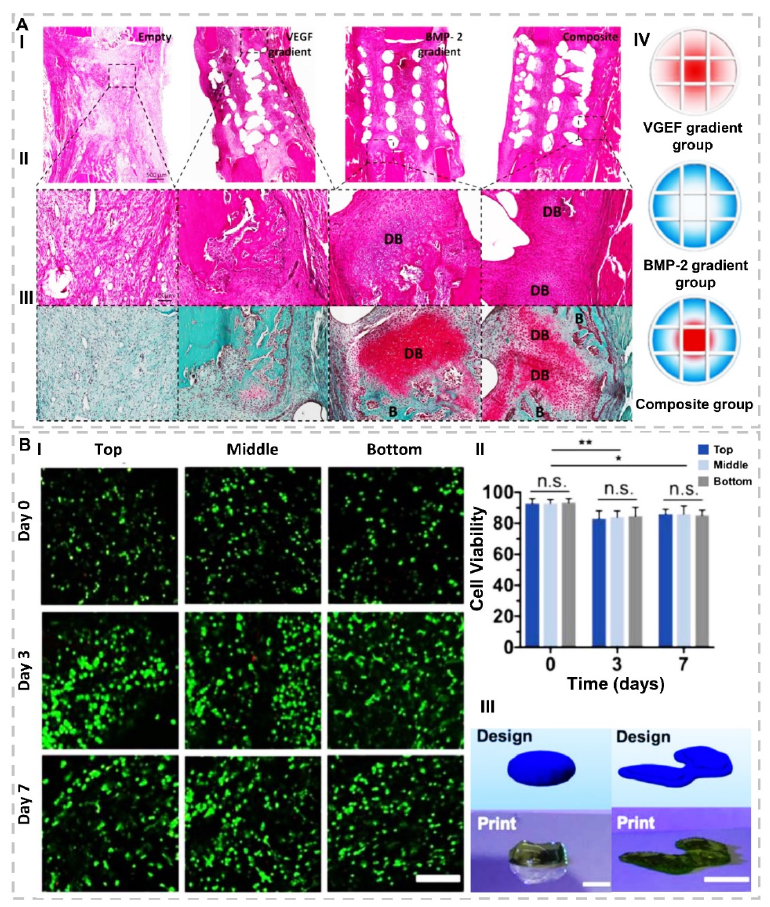
Figure 2. ( A ). Investigation of impact of scaffolds containing BMP-2, VEGF, and their composition on defect regeneration after 2 weeks. (I) H&E stain with 500 µm and (II) with 100 µm scalebar. (III) Safranin O-stained DB points illustrate that cartilage develops to bone by undergoing endochondral ossification, and ( B ) points illustrate new bone tissues. (IV) Sche- matic of 3D-printed experimental groups, including key features of developed bioinks and segmental defect procedure. Construct design (4 mm in diameter, 5 mm in height)(reproduced content is open access) [48]. ( B ). (I) Representative Live/Dead images with 200 µm scale bar for cell viability and distribution in printed constructs for three layers (top, mid- dle, and bottom) of scaffolds (II) quantification of cell viability, for top, middle, and bottom of printed discs after 0, 3, and 7 days of culture. n ≥ 3, * p < 0.05, ** p < 0.01, n.s. = not significant. (III) CAD design in comparison to representative image of a printed construct for designs of (right) a model femoral condyle and (left) a disc (~1.5 mm thickness, ~6.5 mm diame- ter). Scale bars = 1 cm (right) and 5 mm (left)(reproduced content is open access) [65].